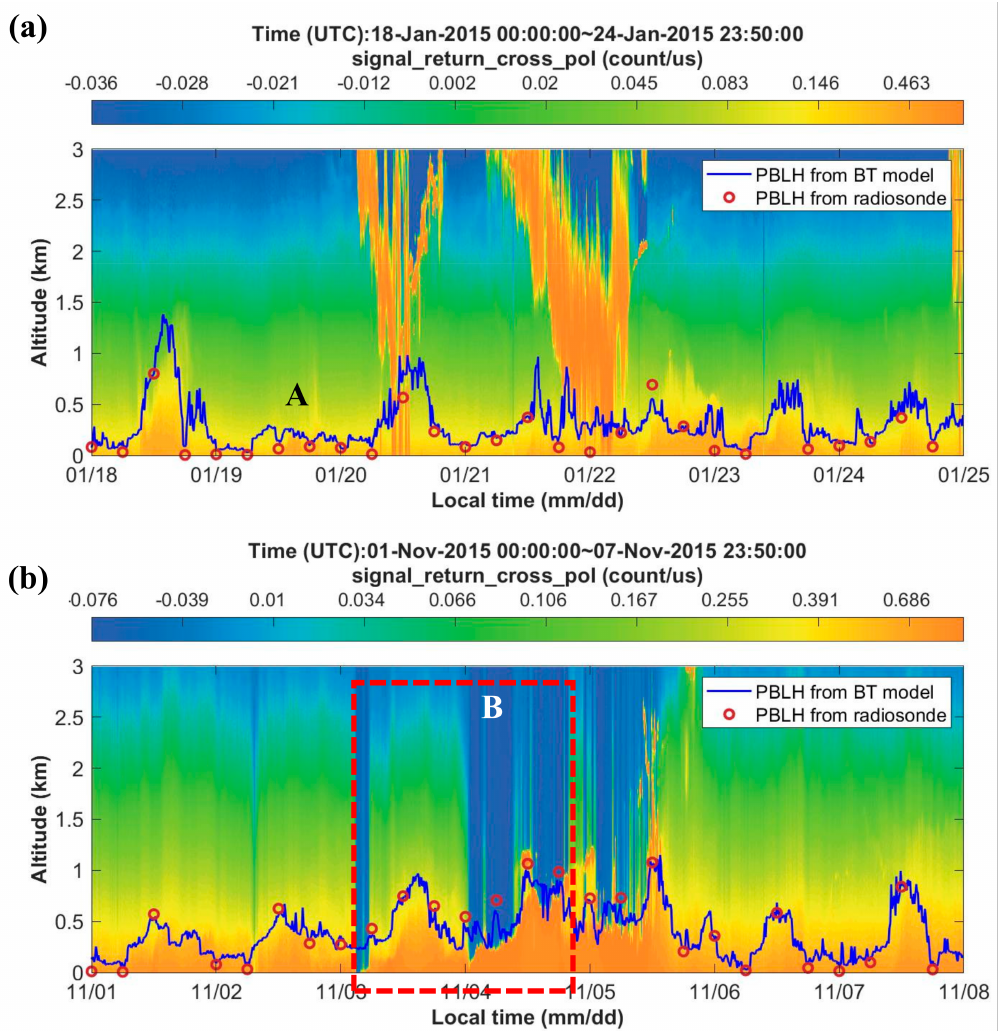
Figure 6. MPL signal measured from ( a ) 18 January 2015 to 24 January 2015 and ( b ) 1 November 2015 to 7 November 2015; PBLHs were determined with the BT model (blue line) and radiosonde (red